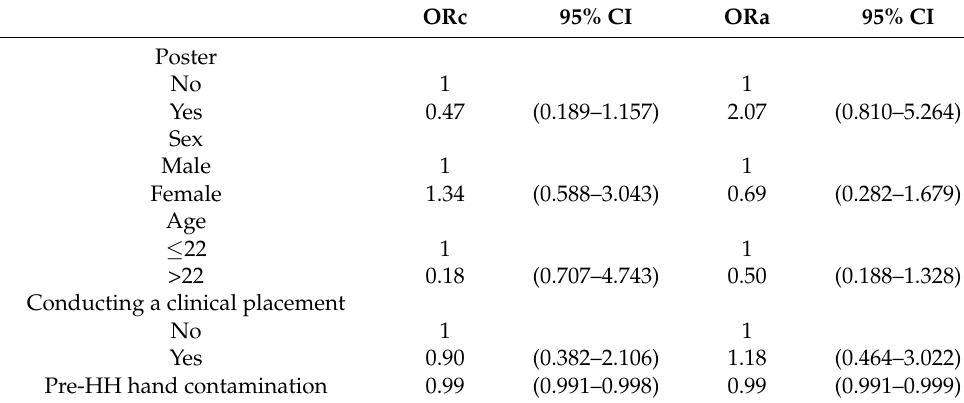
Table 5. Logistic regression for students who passed